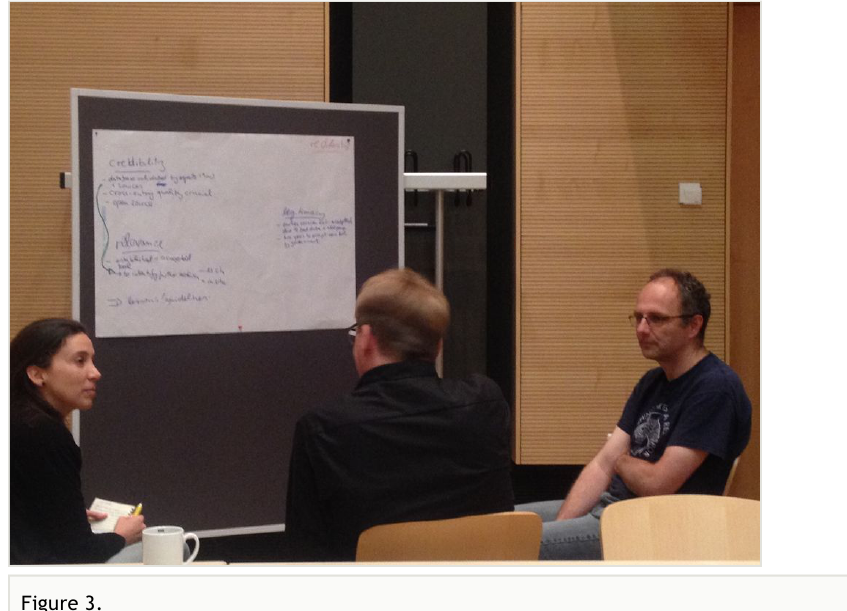
Discussing the development of the “Red Book” of Brazilian plants - case